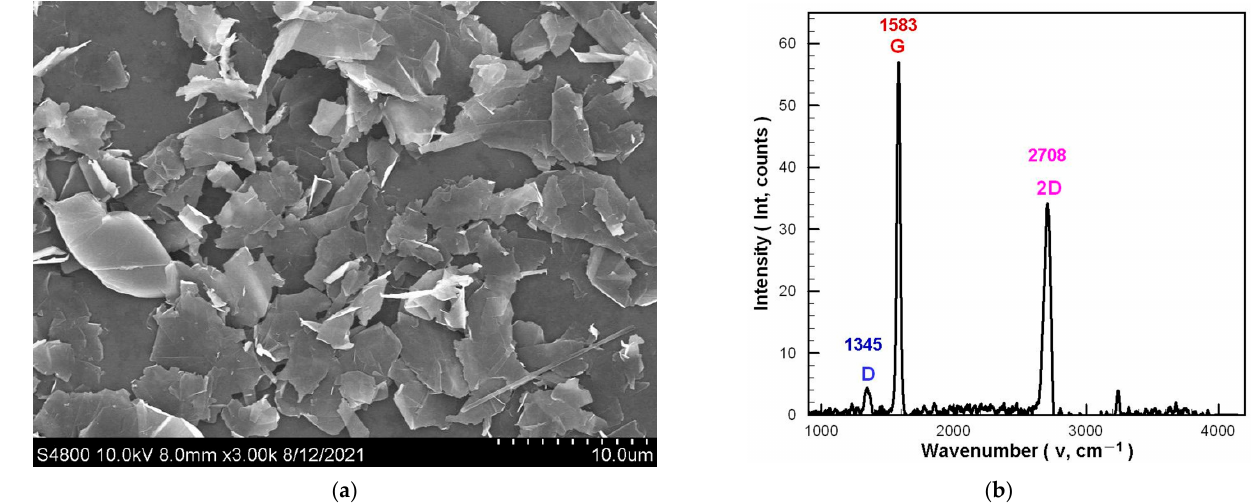
Figure 1. Apparent morphology and material analysis of GN: ( a ) SEM image; ( b ) Raman spectra. In the beginning, the GN is weighed and soaked in isopropanol (IPA, purity: 99.5%; Union Chemical Works Ltd., Hsinchu, Taiwan) to prepare a 2.0 wt % GN-IPA suspension.